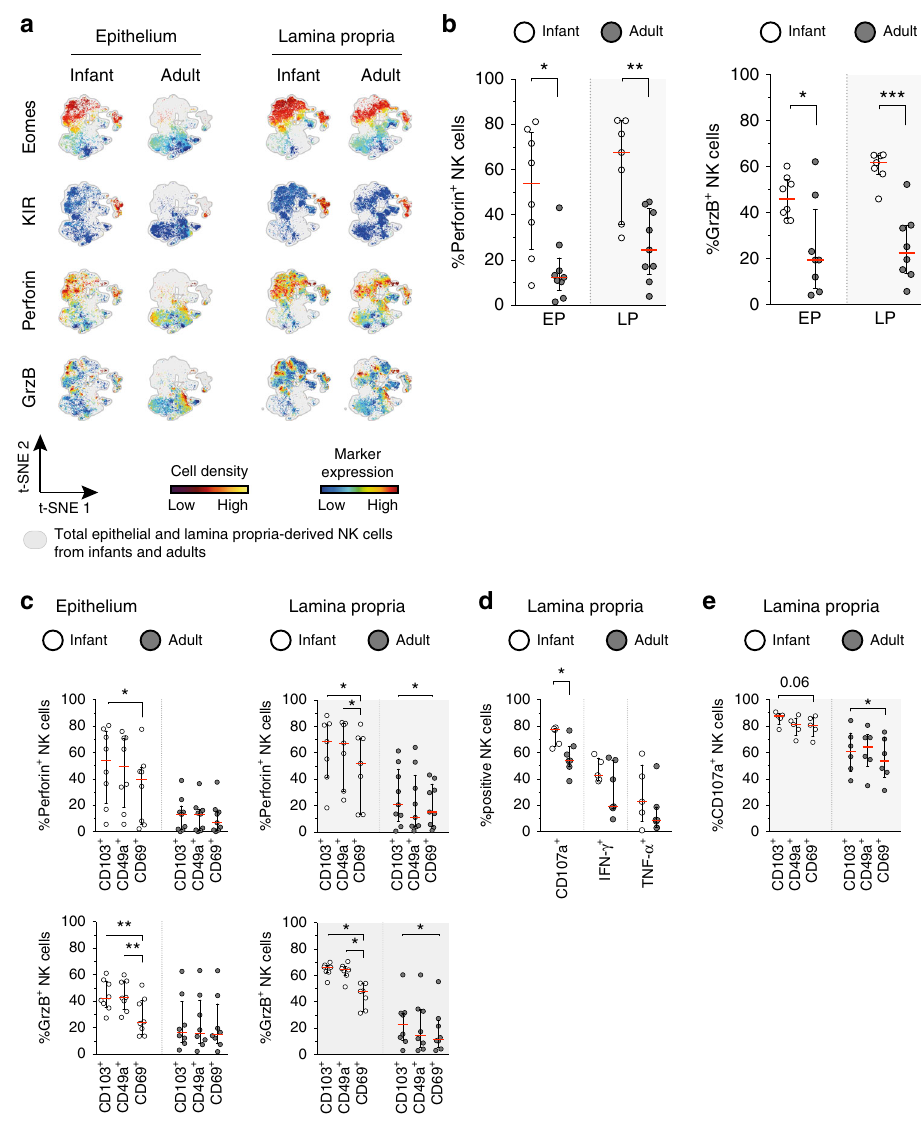
Fig. 6 Infant intestinal NK cells contain high levels of cytotoxic granules. a viSNE plots of combined fl ow cytometric data visualizing Eomes, perforin, granzyme B, and KIR expression by epithelial (EP) and lamina propria-derived (LP) infant and adult NK cells. Expression of Eomes, KIR, perforin, and granzyme B (GrzB) is shown by color coding in relative intensity. viSNE plots have been calculated from concatenated FCS fi les gated on NK cells (infant samples N = 7, adult samples N = 5, iterations = 7500 perplexity = 100, KL divergence = 2.62). b Frequencies of perforin + and GrzB + NK cells in infants (white circles) and adults (dark circles) (EP infant samples ( N = 8), LP infant samples ( N = 7), EP adult samples perforin expression ( N = 9), GrzB expression ( N = 8), LP adult samples perforin expression ( N = 9), and GrzB expression ( N = 8)). c Frequencies of perforin + and granzyme B + cells within CD103 + , CD49a + , or CD69 + NK cell populations in infant (white circles) and adult intestines (dark circles) (EP infant samples ( N = 8), LP infant samples ( N = 7), EP adult samples perforin expression ( N = 9), and GrzB expression ( N = 8), LP adult samples perforin expression ( N = 9), and GrzB expression ( N = 8)). d Frequencies of LP-derived CD107a + , IFN- ɣ + , and TNF- α + NK cells in infant (white circles) and adult intestines (dark circles). Cells were stimulated for 6 h with phorbol 12-myristate 13-acetate (PMA) and ionomycin (infant samples N = 5, adult samples N = 7). e Frequencies of LP-derived CD107a + cells within CD103 + , CD49a + , or CD69 + NK cell populations in infant (white circles) and adult intestines (dark circles) after stimulation with PMA and ionomycin for 6 h (infant samples N = 5, adult samples N = 6). Median frequencies indicated by red lines. Error bars de fi ne interquartile ranges between 75th and 25th percentiles. Statistical comparisons are Mann-Whitney U comparisons ( b , d ) and Wilcoxon matched-pairs signed rank tests ( c , e ). Asterisks represent the following p- values: * p < 0.05; ** p < 0.01; and *** p <